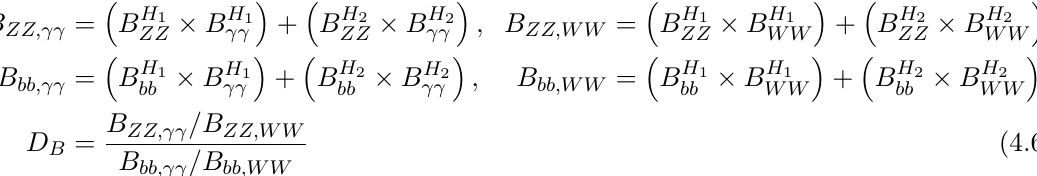
Figure 12 . All surviving samples in figure 5 are projected on plots m H The colorbar represents the likelihood value in eq. (4.5). Samples with green color are in better agreement with the recent experimental result of ( g − 2) agreement with the